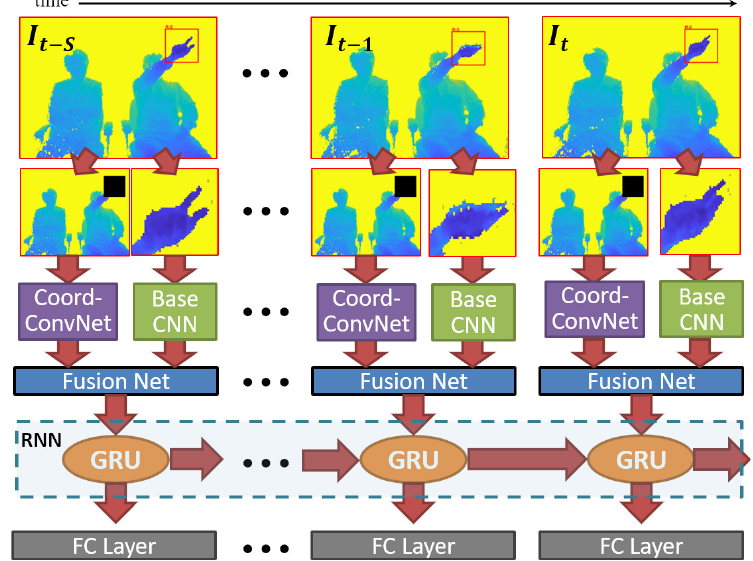
Figure 4. The frame-wise process of our multi-stream RNN. In the first stream, the input frame is overlaid by a black mask in the hand location and processed by a CoordConv network (purple colored block). On the second stream, the hand region is cropped and processed by the base CNN (green colored block). The fusion network combines both types of features for feeding the RNN with GRU cells. Finally, a fully connected layer outputs confidence scores of possible proposals ending at the current